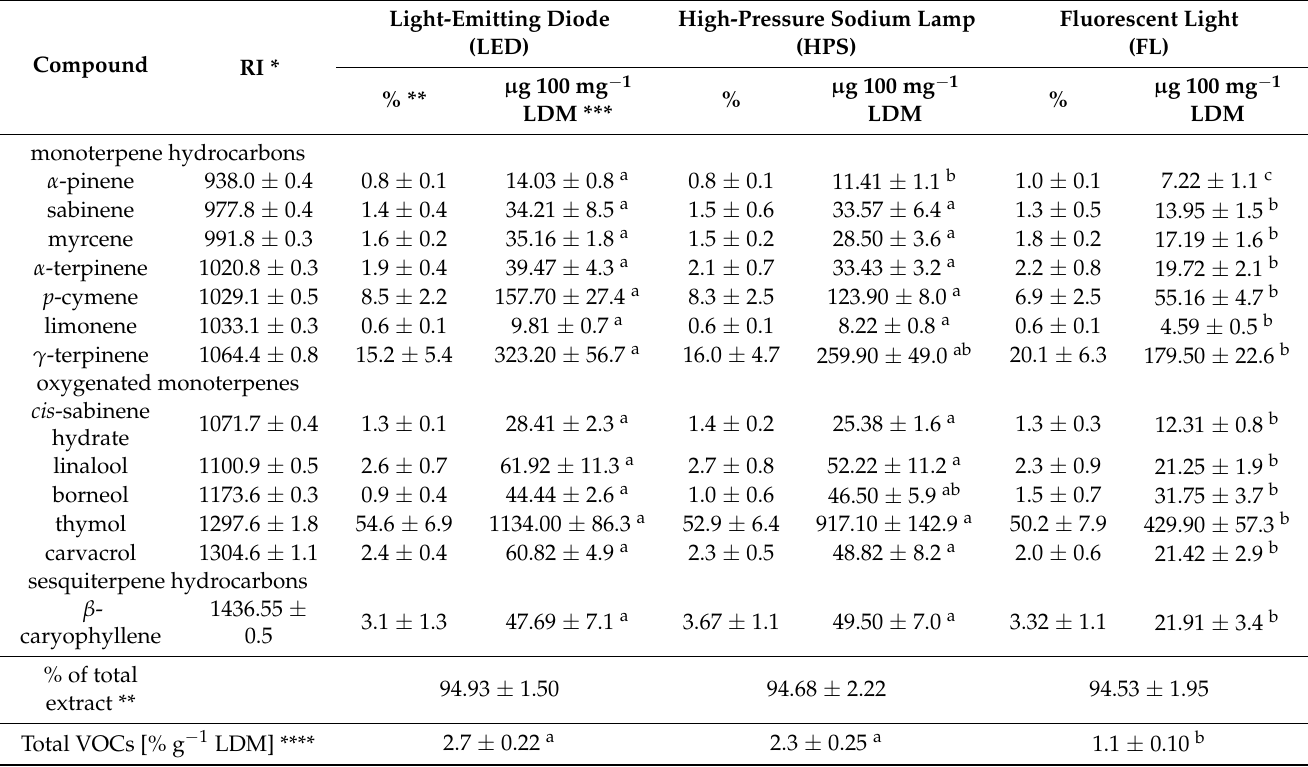
Table 2. Effect of three different supplemental lighting systems on the chemical composition of 13 main volatile organic compounds (VOCs) of Thymus vulgaris L. cultivated in the greenhouse during fall and winter of Berlin,